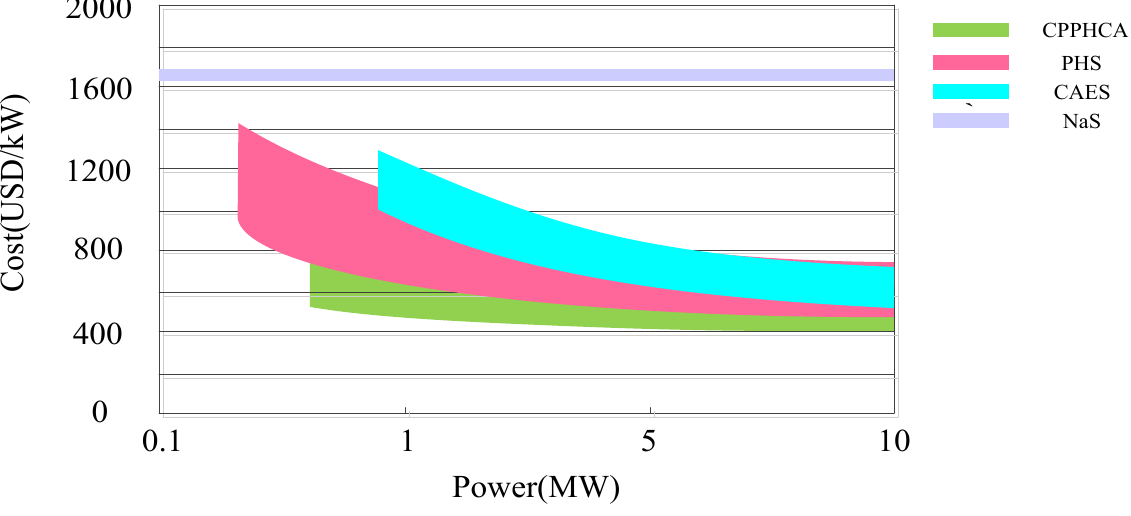
Figure 9. Economic comparison of energy storage system. CPPHCA: constant-pressure PHCA; PHS: pumped hydro storage; and CAES: compressed air energy